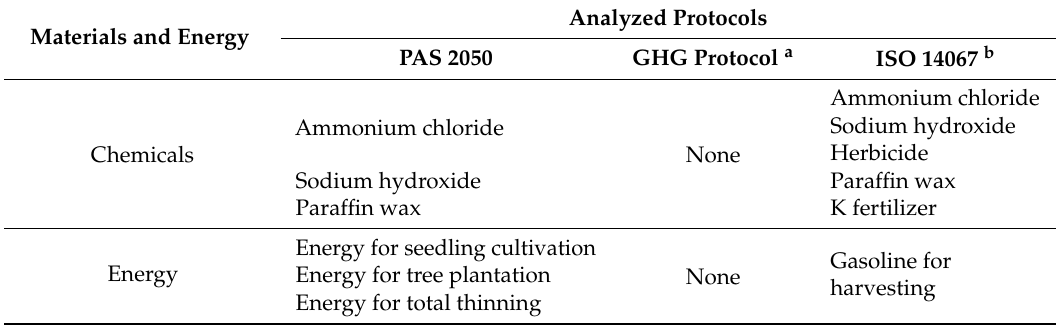
Table 2. Materials and energy excluded from the cradle-to-gate assessment due to cut-off